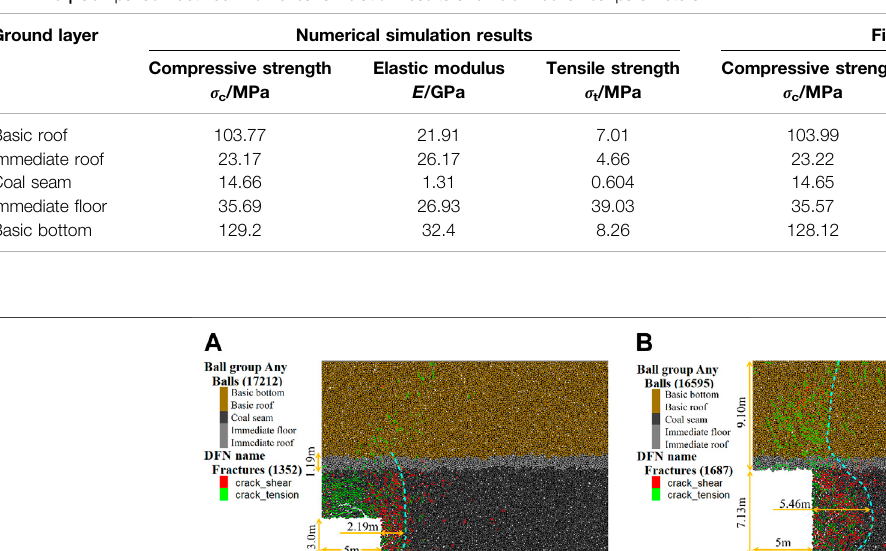
TABLE 3 | Comparison between numerical simulation results and fi eld mechanical